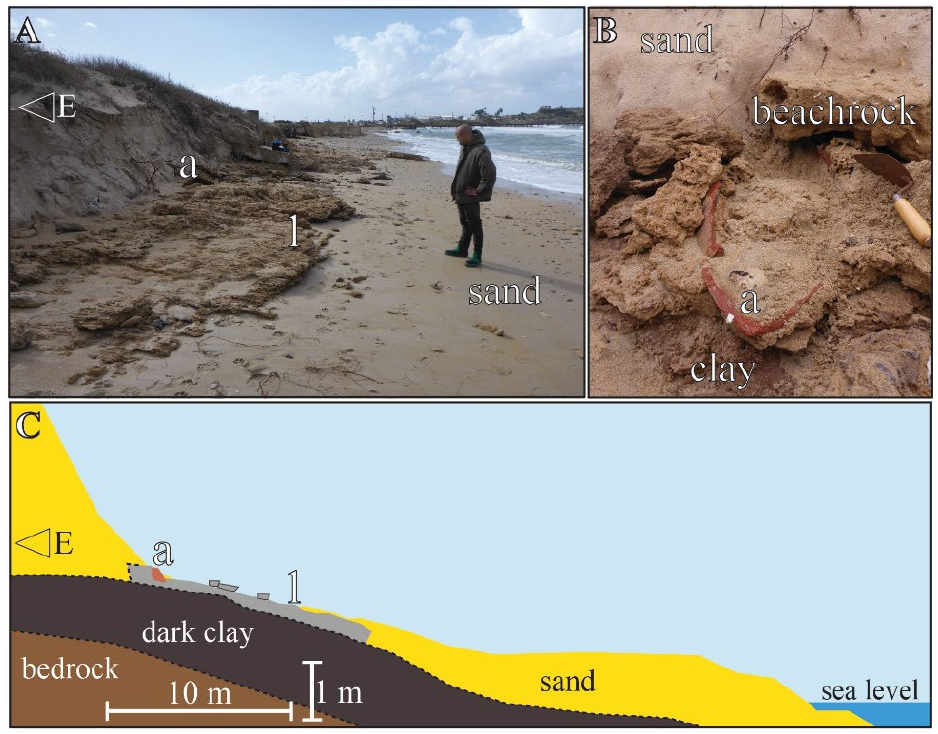
Figure 9. Beachrock exposure near the Crusader cemetery at Atlit: ( A ) view of the site ( 1 : BR outcrop, ( a ) ceramic jar consolidated inside the BR); ( B ) close-up (looking east) of outcrop surface (( a ) as in ( A )); ( C ) schematic cross-section of the site (VE = 4, dotted line marks uncertain unit contact depth, other notes are as in (A)).